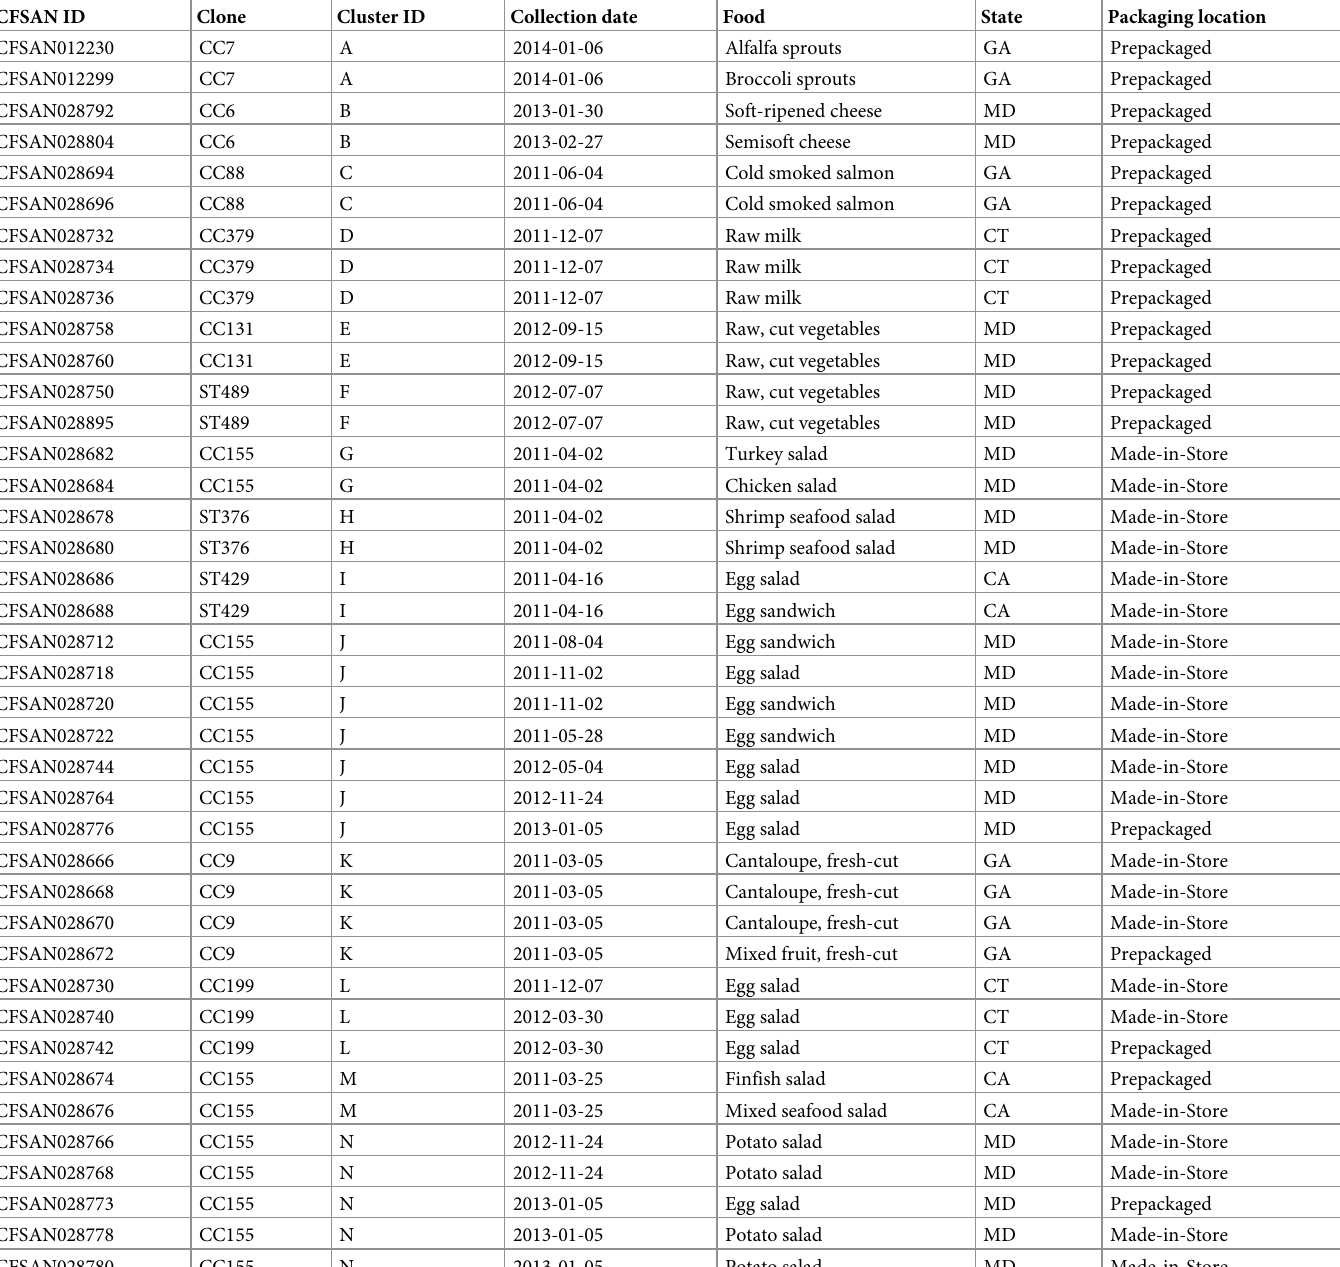
Table 3. Clusters of isolates involved in possible transmission and persistence